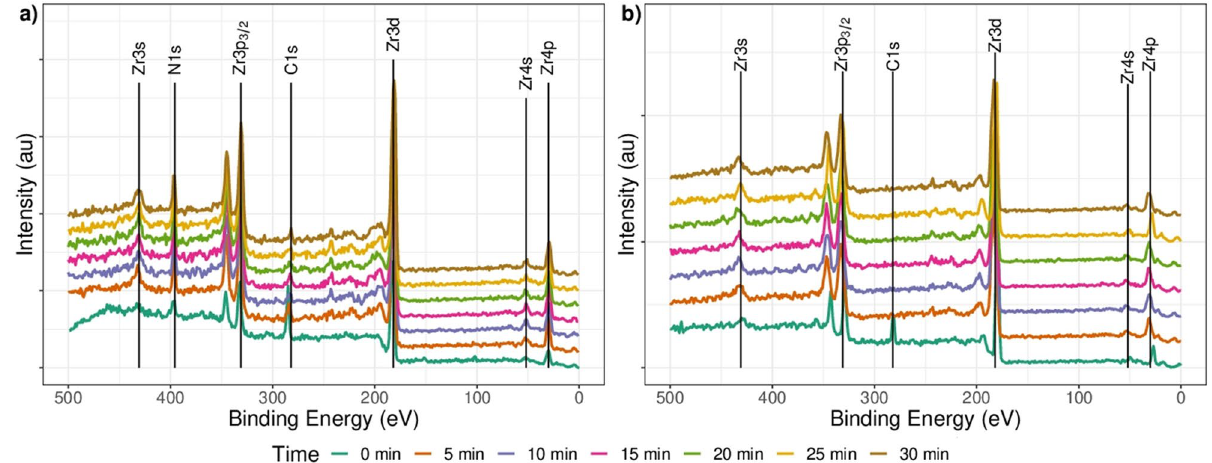
Figure 1. General spectrum for ( a ) ZrN-ZrO x N y and ( b ) ZrO 2 -ZrO x N y coating on AISI 316L. Depth profile 0, 5, 10, 15, 20, 25 and 30 min.